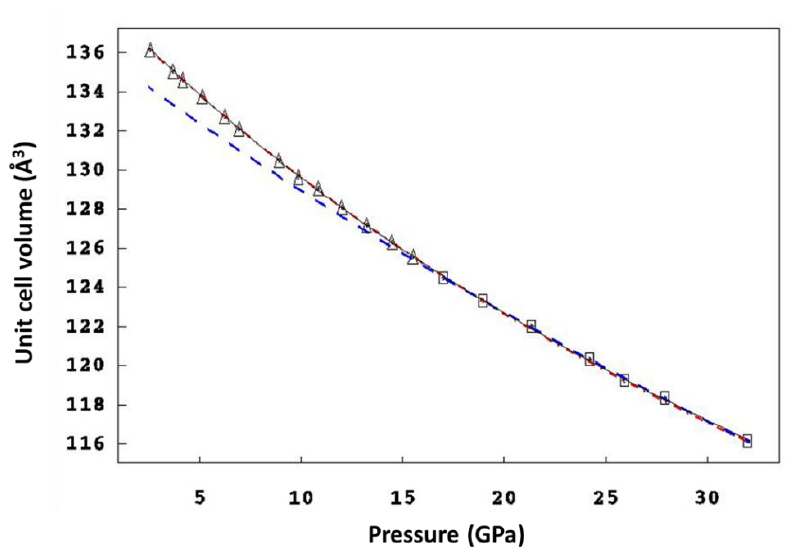
Figure 7. Volumetric data (triangles and squares) of goethite as a function of pressure derived from the x-ray diffraction. Errors are smaller than the size of the symbols. The red dot-dashed line, blue dashed line, and thin solid line represent the equation of state (EOS) fitting of the data from 0 to 16 GPa (triangles), 16 to 32 GPa (squares), and 0 to 32 GPa.